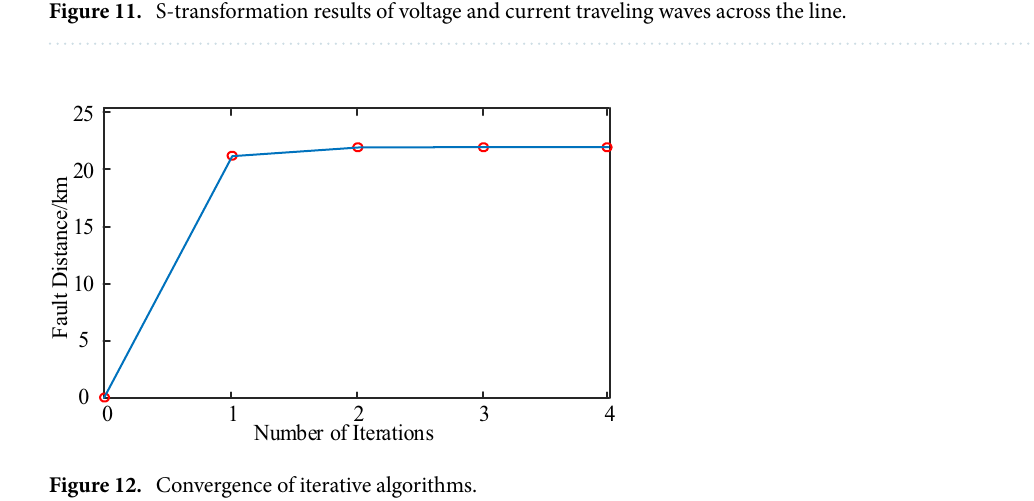
Figure 11. S-transformation results of voltage and current traveling waves across the line.